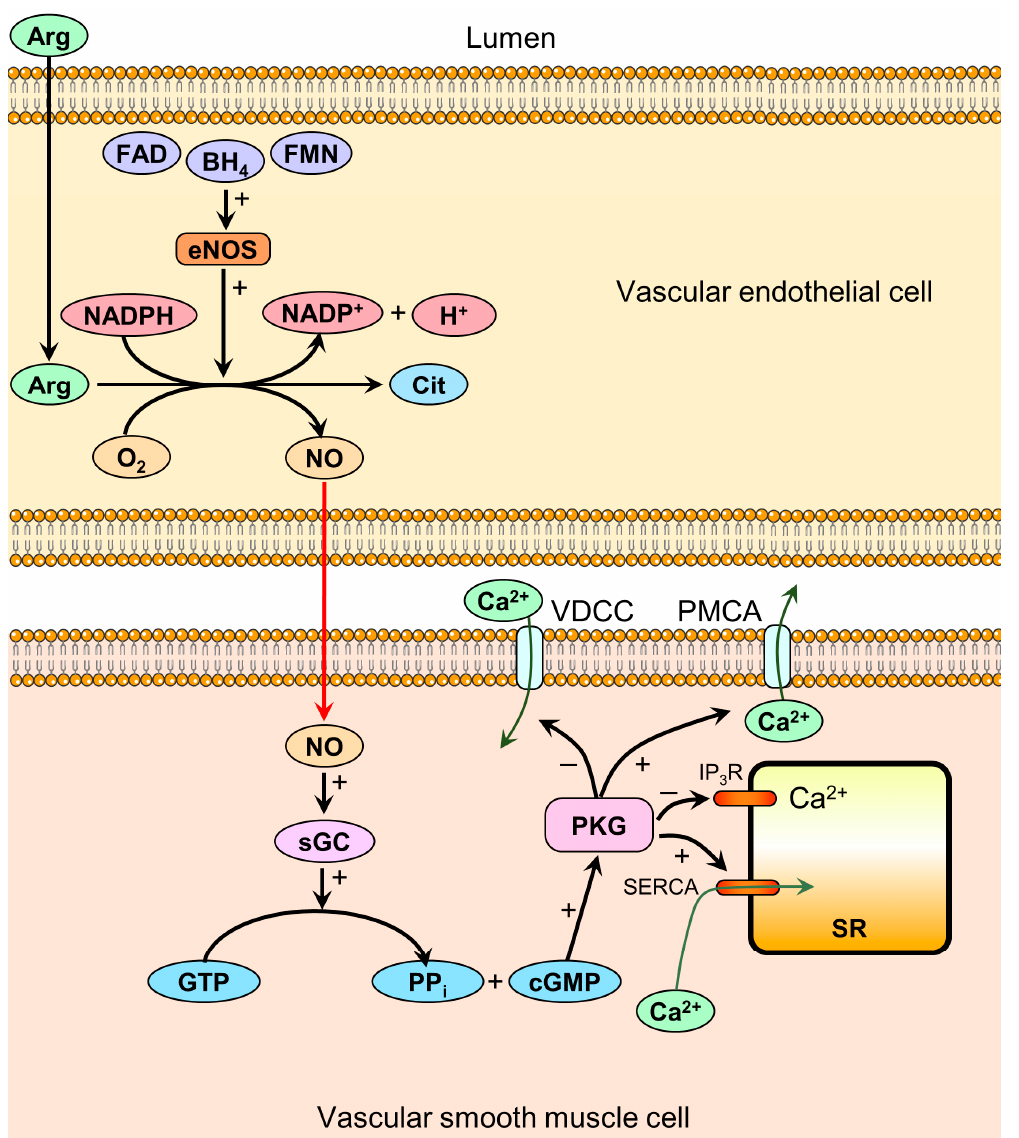
Figure 1. Mechanisms of nitric oxide-mediated vasodilation. Plasma Arg provides the substrate for the synthesis of nitric oxide (NO) via the enzyme endothelial nitric oxide synthase (eNOS) located in the vascular endothelium. The enzymatic reaction requires the co-substrates O 2 and nicotinamide adenine dinucleotide phosphate (NADPH) and the cofactors BH 4 , flavin adenine dinucleotide (FAD), and flavin mononucleotide (FMN). NO diffuses from the endothelial cell to the smooth muscle cell and activates soluble guanylyl cyclase (sGC), resulting in increased cyclic guanosine monophosphate (cGMP) production. cGMP subsequently activates protein kinase G (PKG), resulting in decreased [Ca 2+ ] i via at least four mechanisms: 1. Inhibition of voltage-dependent calcium channels (VDCC), reducing calcium influx. 2. Activation of plasma membrane calcium ATPases (PMCA), increasing ATP-dependent calcium efflux. 3. Inhibition of inositol triphosphate receptors (IP 3 R), reducing calcium release from the sarcoplasmic reticulum (SR) to the cytoplasm. 4. Activation of sarcoplasmic calcium ATPases (SERCA), increasing the ATP-dependent sequestration of calcium from the cytoplasm to the SR. Decreased [Ca 2+ ] i mediates smooth muscle relaxation via the activation of myosin light chain kinase and the inhibition of myosin light chain phosphatase (not shown in figure), resulting in vasodilation.